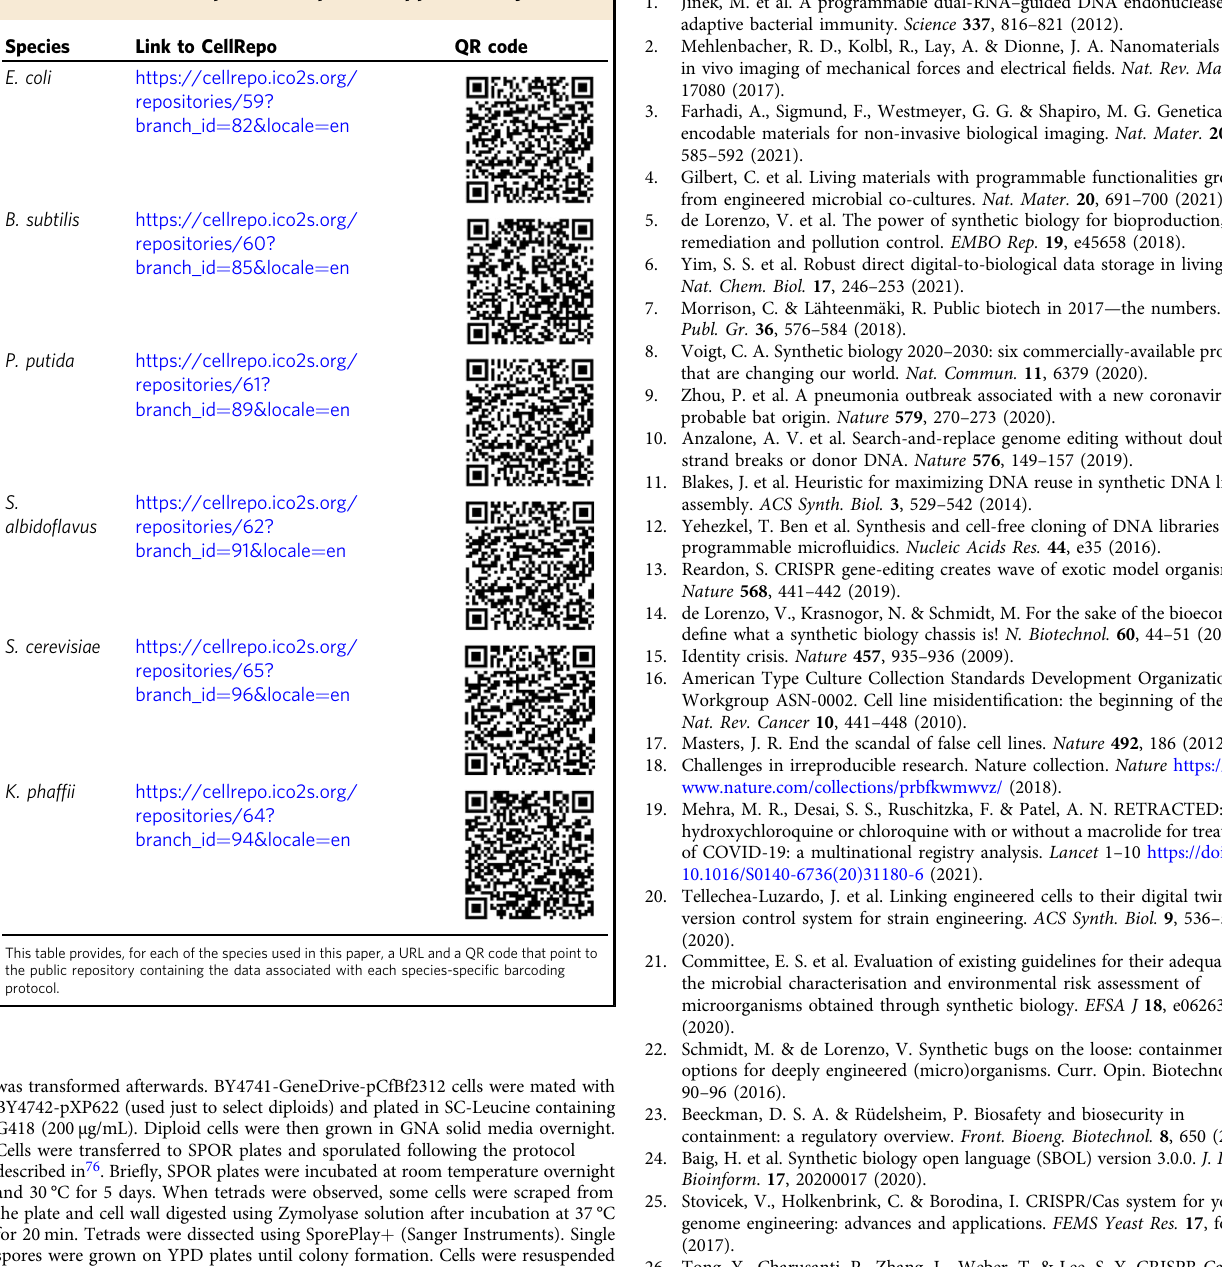
Table 1 List of CellRepo-hosted public supplementary